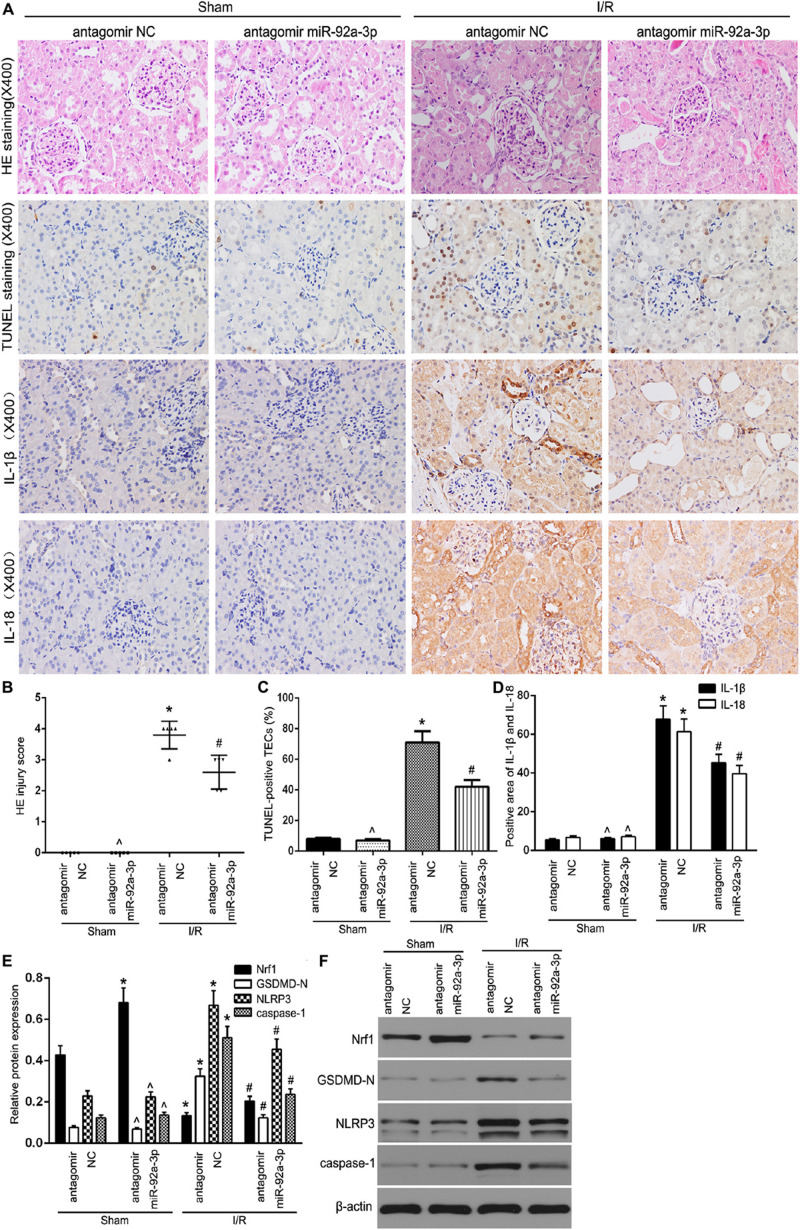
The inhibition of miR-92a-3p alleviated TEC pyroptosis in I/R-induced kidney of mice. (A) Representative photomicrographs of tubular cell injury in mouse kidney tissue sections with HE staining, TUNEL staining, and representative photomicrographs of IL-1β and IL-18 expression in mouse kidney tissue sections by immunohistochemistry, 400×, scale bar = 20 μm. (B) Statistical quantification analysis showed the injury score of HE staining in the kidney tissues. (C) Statistical analysis showed the percentage of TUNEL-positive TECs in the kidney tissues. (D) Statistical analysis showed the positive area of IL-1β and IL-18 in the kidney tissues. (E,F) Western blot analysis of Nrf1, GSDMD-N, NLRP3, and caspase-1 expression in mouse kidney tissue sections. SCr levels (G) and BUN levels (H) were detected in mice. Data are expressed as the mean ± SD. n = 5 per group. *P < 0.05 vs. antagomir NC sham group. ∧P > 0.05 vs. antagomir NC sham group. #P < 0.05 vs. I/R-induced antagomir NC group, one-way ANOVA.